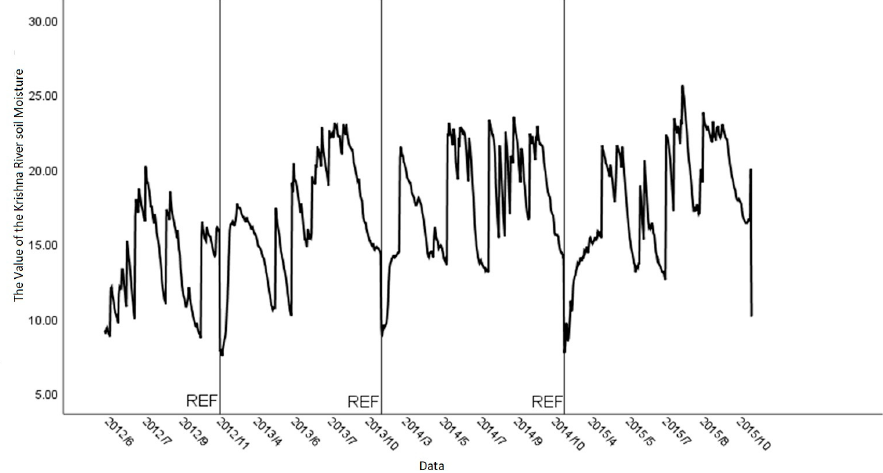
Figure 10. Forecast of testing data—Krishna Soil Moisture Dataset.